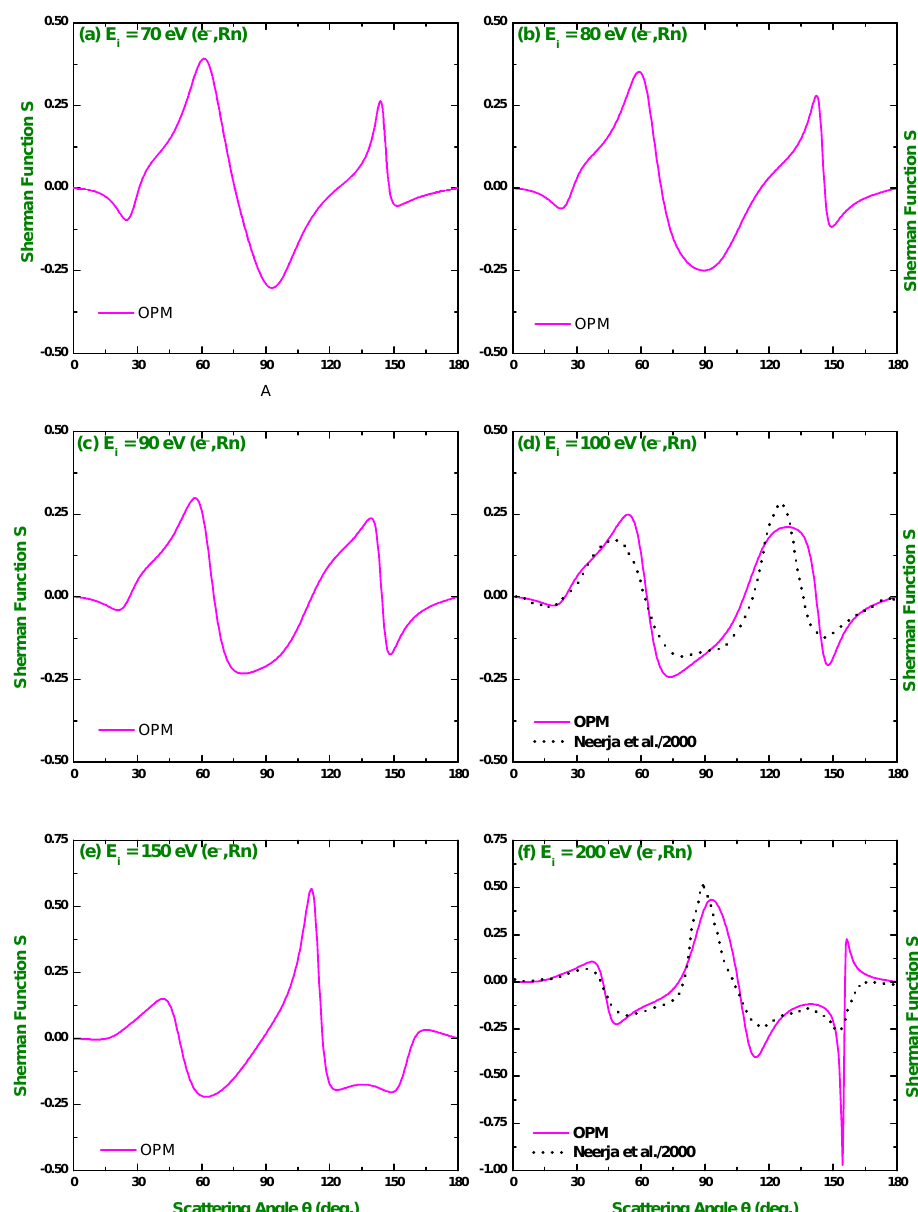
Figure 11. Same as Figure 10, but at impact energies of 70, 80, 90, 100, 150 and 200 eV. Because of the absence of any experimental data we compare our S results again with the calculations of Neerja et al. [19], available at 10, 50, 100 and 200 eV, and of Sin Fai Lam [13], available at 20 and 30 eV. Similar to the DCS comparison, one can observe that these three calculations of Sherman function agree closely with one another with the deviations as follows: (i) a tiny differences in magnitude of | S | at the minima or maxima positions, (ii) at 10 eV, present method predicts a minimum at 110 ◦ , while that from [19] is observed at 100 ◦ , (iii) at 50 eV, the third extremum predicted by the present method and that of Neerja et al. [19] are opposite in sign. All of these differences might be attributed due to the different components of optical potentials used in these two methods as already mentioned earlier. More data and calculations might be helpful to shed light on the presence of these